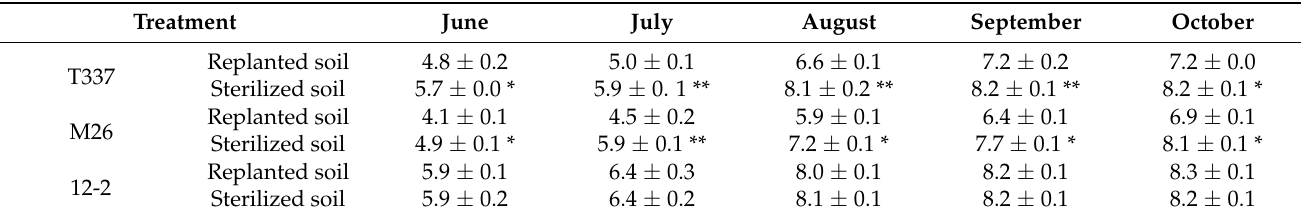
Table 2. The stem thickness (mm) of the plants with different rootstock types planted in sterilized and replanted soil.